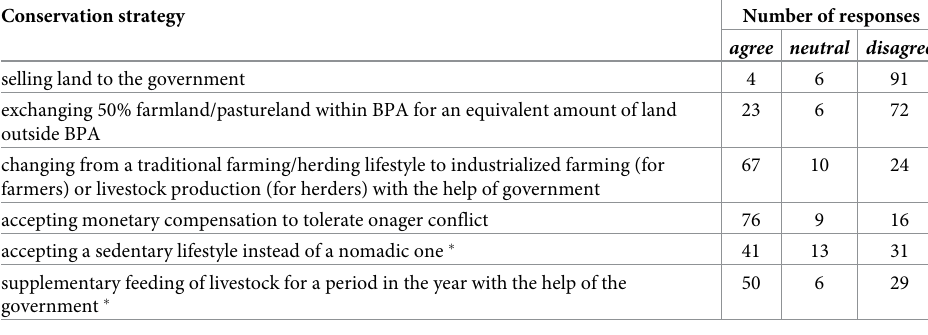
Table 3. Acceptability of potential management strategies aimed at reducing human-onager conflict according to 101 farmers and herders within Bahram-e-Goor Protected Area (BPA), Iran. Conservation